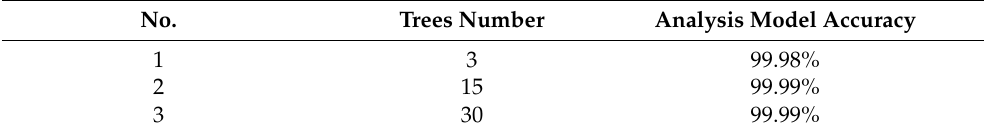
Table 3. The parameters of the intrusion detection model training when training in a centralized manner.